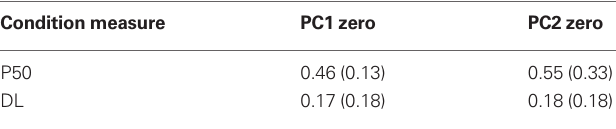
Table 2 | Median (iQr) of P50 and DL for all